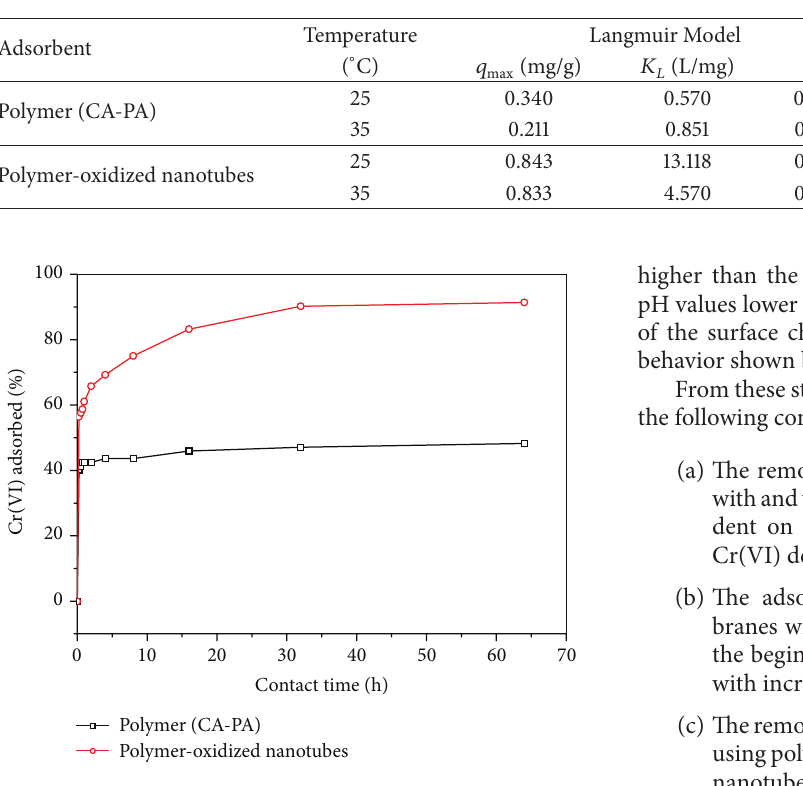
Figure 16: Chromium adsorption kinetics for polymeric mem- branes with carbon nanotubes (pH